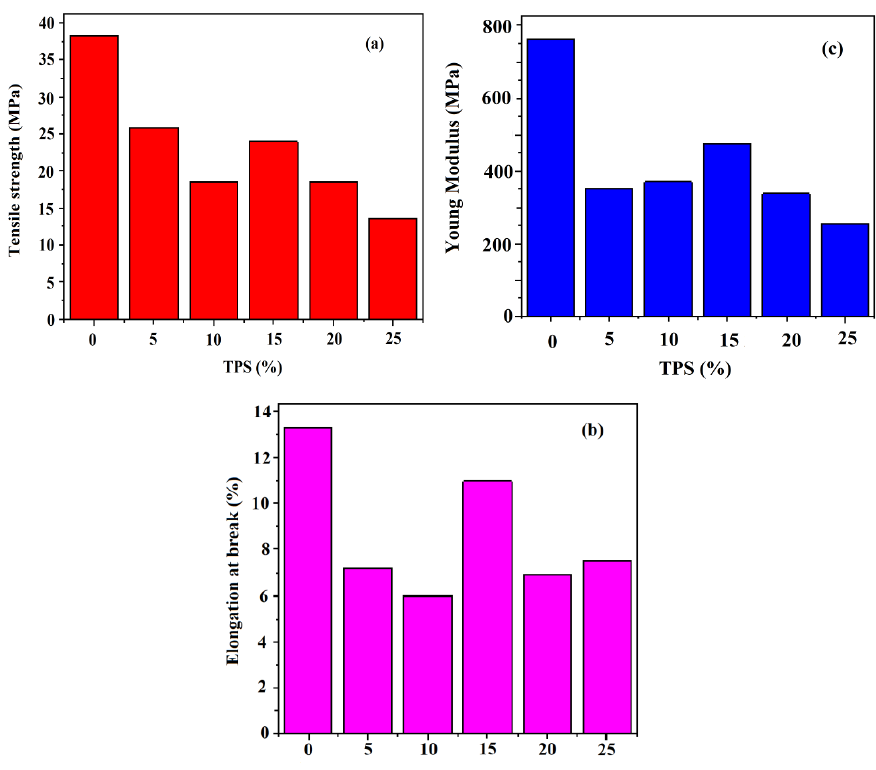
Fig. 8. (a) Tensile strength, (b) Elongation at break (%) and (c) Young’s modulus as function of the TPS